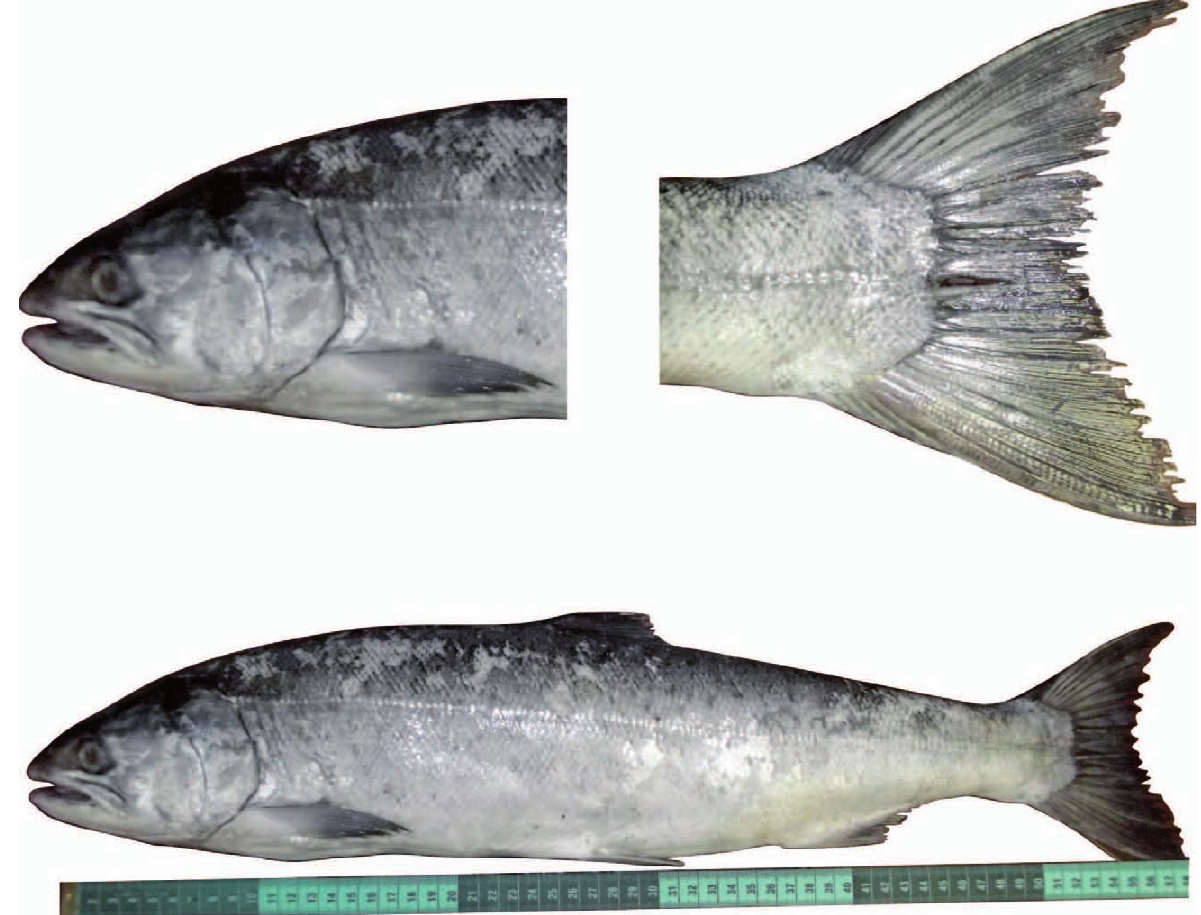
Fig. 2. Female of coho salmon, Oncorhynchus kisutch (ENIP-CI-387), 520 mm SL, collected at Las Barrancas,